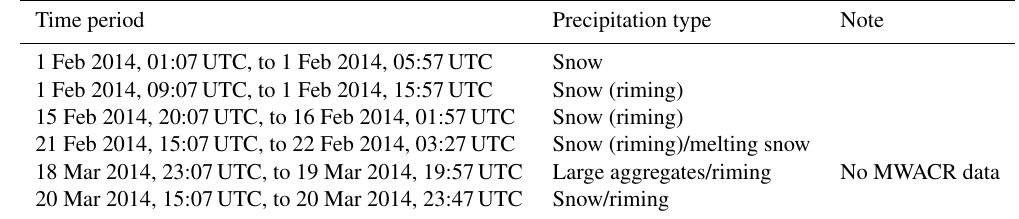
Figure 1. (a) Schematic of the spatiotemporal matching of the in situ (PIP) observations and the cloud radar observations. Radar spectra at time t and range r are assigned to the PIP measurement closest to the time t + x . (b) Processing steps applied to each extracted radar Doppler spectrum. (c) A 3D plot of three features containing the resulting training data set (equivalent radar reflectivity factor Ze, spectrum edge width SEW, and skewness) colored by the rime mass fraction, FR. Table 1. Overview of the cases used in the training set and coincident notable events according to Table 2 in Petäjä et al.